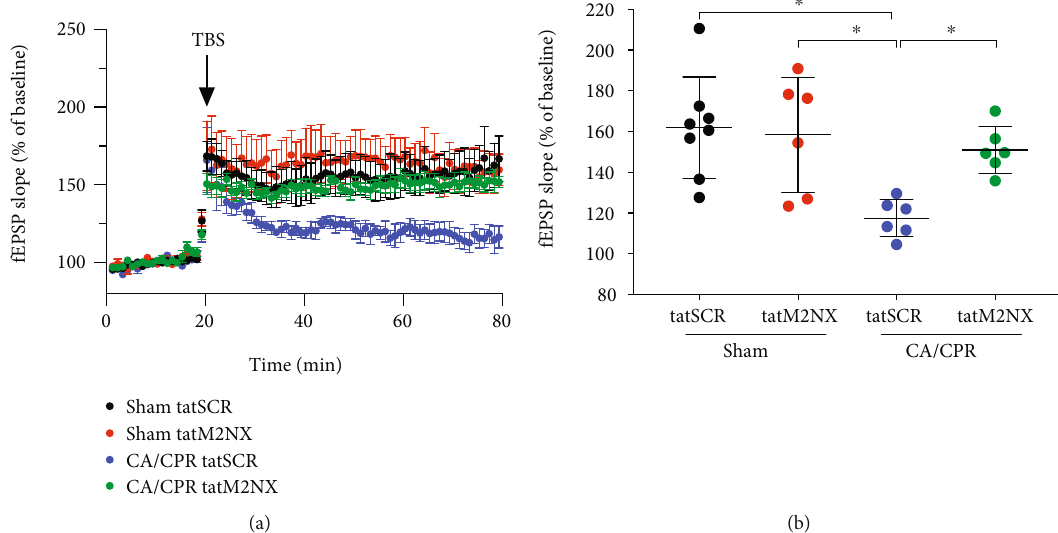
Figure 3: Delayed inhibition of TRPM2 with tatM2NX restores synaptic plasticity. (a) Time course of fEPSP slope 14 days after sham mice were treated on day 13 with 20mg/kg tatSCR (black) or tatM2NX (red) and 14 days after CA/CPR mice were treated on day 13 with 20mg/kg tatSCR (blue) or tatM2NX (green). (b) Quanti fi cation of change in fEPSP slope 60 minutes after TBS stimulation normalized to 20 minutes of baseline recording (set at 100%). Each point represents one hippocampal slice, with no more than 2 slices from an individual mouse. ∗ p < 0 : 05 by one-way ANOVA.